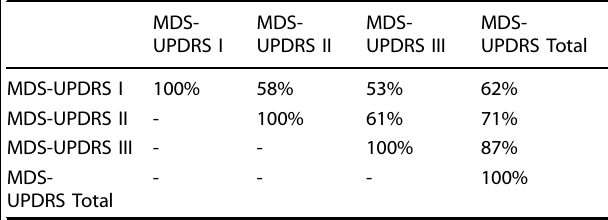
Table 2. Heterogeneity in 12-month MDS-UPDRS subpart